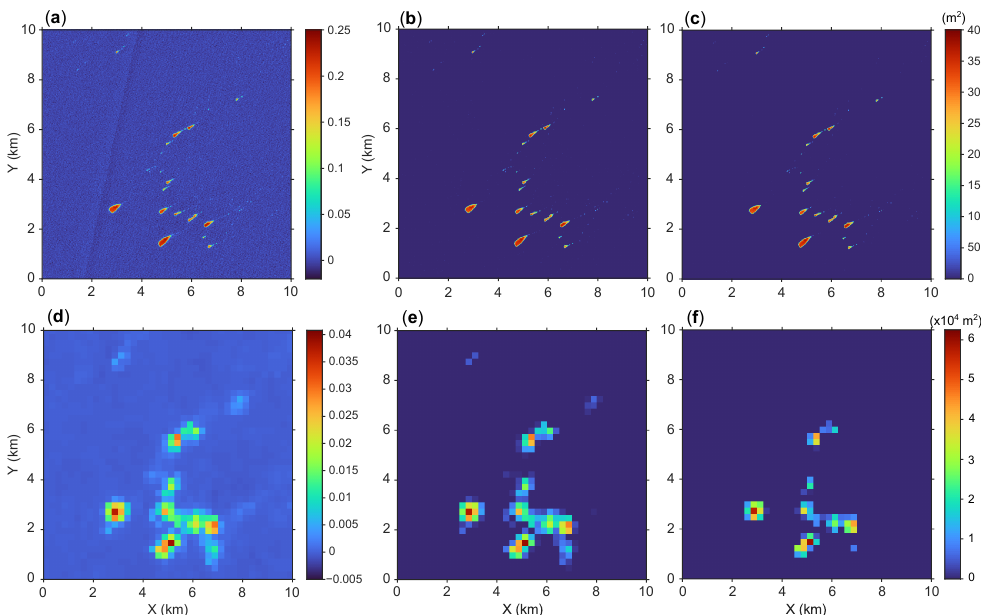
Figure 4. Examples of sFAI images captured on 7 May 2020, in the East China sea by ( a ) Sentinel- 2/MSI and ( d ) GCOM-C/SGLI. The origin of the axis was located at 125.2491 ◦ E in longitude and 30.4338 ◦ N in latitude. Panels ( b , c ) display the macroalgae area (in m 2 ) in each pixel generated from the sFAI map of panel ( a ). Macroalgae area was computed using Equation (6), which required upper and lower sFAI thresholds (sFAI max and sFAI min ). In panels ( b , c ), the identical sFAI max (0.22), but different sFAI min values were used; in ( b ), sFAI min was the sFAI value at 99.7% in the cumulative histogram of sFAI, while in ( c ), sFAI min was at 99.9% in the cumulative histogram of sFAI. ( e , f ) were identical to ( b , c ), except for GCOM-C/SGLI sFAI with the same sFAI max value of 0.0408. Due to the high spatial resolution of Sentinel-2/MSI sFAI (Figure 4a), massive macroal- gae blooms (red colored area) were composed of many pixels. Sentinel-2/MSI had an sFAI value of around 0.25 in some pixels but 0.22 in the center of large macroalgae patches; thus, a sFAI max of 0.22 would be reasonable for Sentinel-2/MSI. Figure 4b,c present macroalgae area in each pixel, calculated using Equation (6) and Sentinel-2/MSI pixel area (20 × 20 m 2 ) with sFAI min at 99.7% (Figure 4b) and 99.9% (Figure 4c). The total macroalgae area of Sentinel-2/MSI sFAI in the test area was about 1.289 and 1.062 km 2 for sFAI min of 99.7% and 99.9%, respectively. The highest GCOM-C/SGLI FAI value is 0.0408, making it a candidate for sFAI max . When we set 0.0408 for sFAI max and computed the macroalgae area using Equation (6), we obtained 3.331 and 2.049 km 2 for sFAI min at 99.7% and 99.9%, respectively (Figure 4e,f). Despite missing small patches of floating macroalgae (especially in the case of sFAI min = 99.9%), GCOM-C/SGLI sFAI produced two to three times more macroalgae area than Sentinel-2/MSI sFAI. Thus, using GCOM-C/SGLI sFAI with sFAI max of 0.0408 possibly overestimated macroalgae area. When we set 0.1 to GCOM-C/SGLI sFAI max , which was approximately 2.5 times of 0.0408, we obtained macroalgae area of 1.299 and 0.761 km 2 for sFAI min at 99.7% and 99.9%, respectively. From this comparison, we assumed sFAI max for GCOM-C/SGLI would be between 0.0408 to 0.1, and we considered 0.04, 0.07, and 0.1 in the following analysis. Here, we rounded 0.0408 down to 0.04 and added 0.07 as an intermediate number. So, we computed the total macroalgae area using combinations of three sFAI max (0.04, 0.07, and 0.1) and three sFAI min (99.7%, 99.9%, and 99.99% in the cumulative frequency of sFAI). The absence of ground truth data made the selection and validation of optimal values of sFAI min and sFAI max difficult; thus, we assumed the variation of the estimated macroalgae area due to sFAI max and sFAI min (i.e., sensitivity to sFAI max and sFAI min ) to be the possible macroalgae area